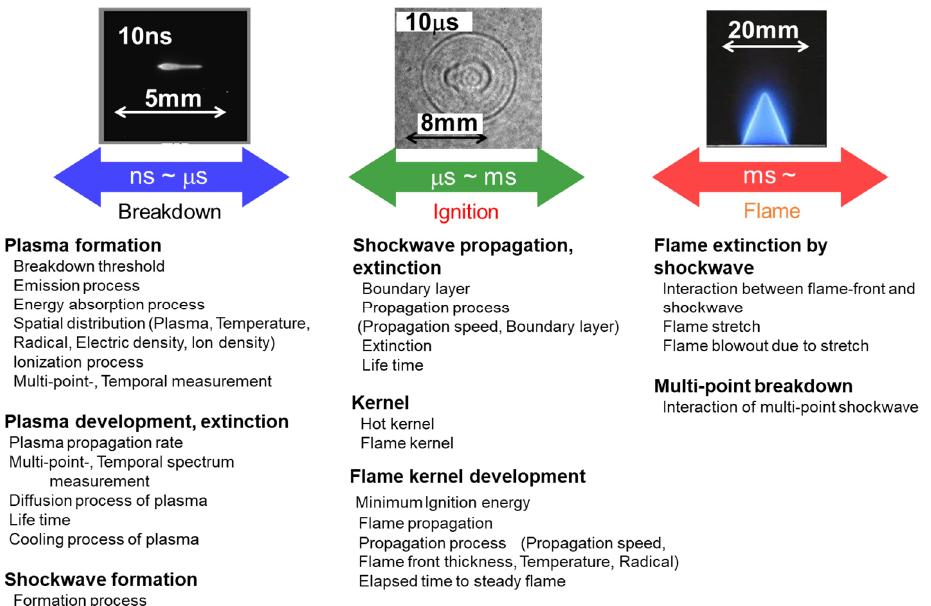
Figure 1. Physicochemical process of combustion.